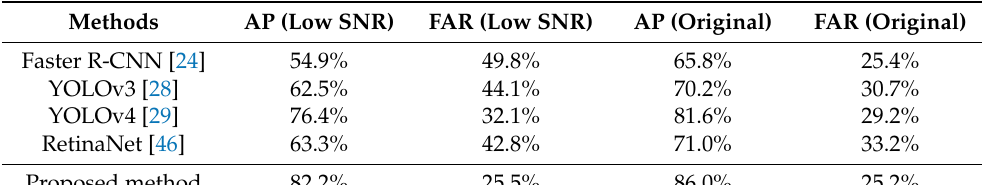
Table 2. Results of the comparative experiment.